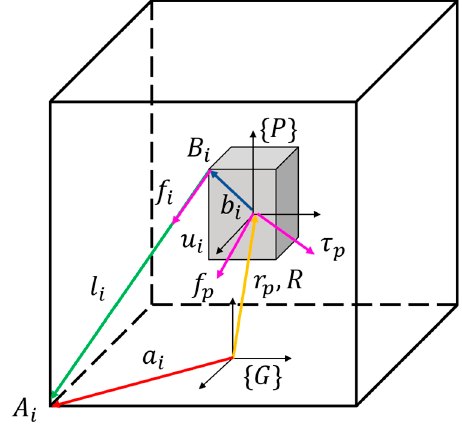
Figure 1. Kinematic geometry of the i th c able in CDPR.